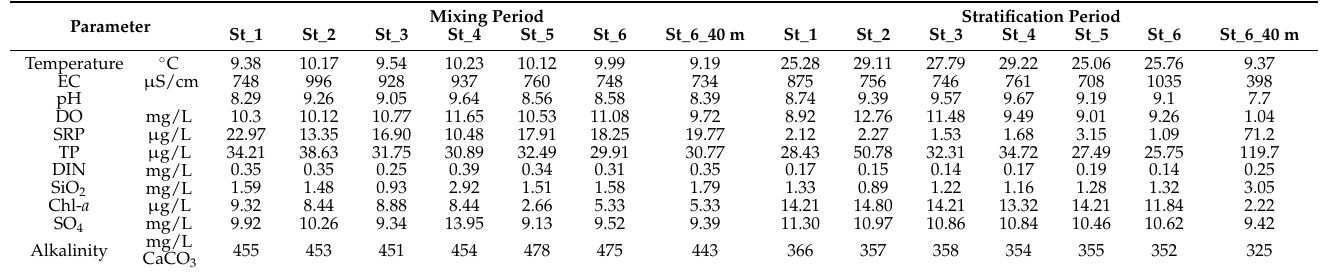
Table 1. Water quality of the lake during the sampling